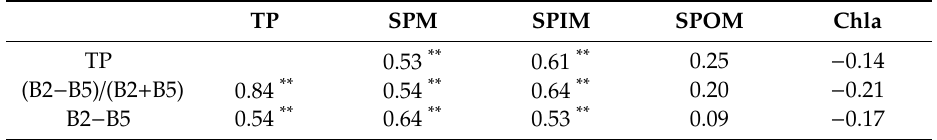
Table 4. The correlation coe ffi cient between the water quality index and band combination of MODIS. TP SPM SPIM SPOM Chla TP 0.53